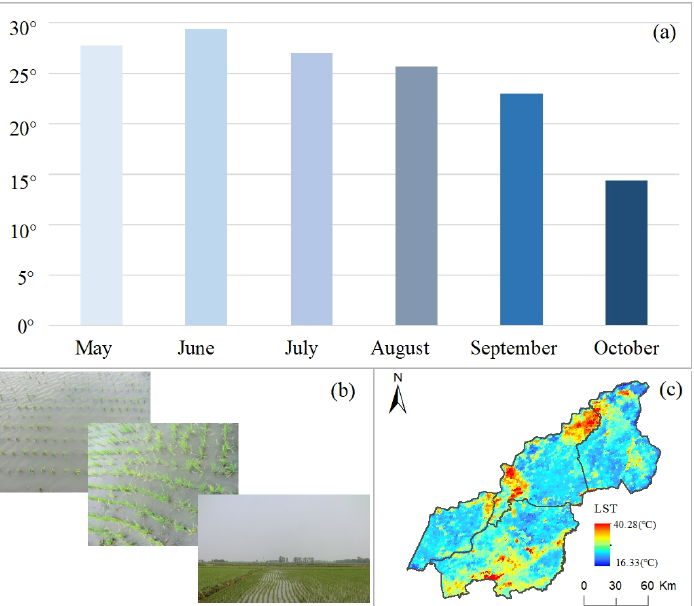
Figure 6. Land surface temperature of paddy field across the growing seasons from 2000 to 2020. Note: ( a ) the average temperature from a paddy field each month across the growing season, ( b ) field investigation of paddy field in the study area and ( c ) spatial pattern of land surface temperature in July of the study area.